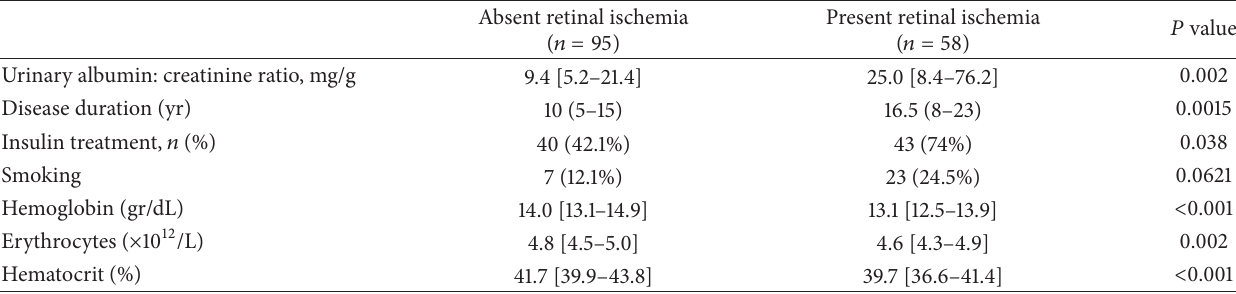
Table 3: General and hematological variables that showed statistically significant differences in the comparison between groups according to the presence or absence of retinal ischemia in the group of patients with diabetic retinopathy. Absent retinal ischemia